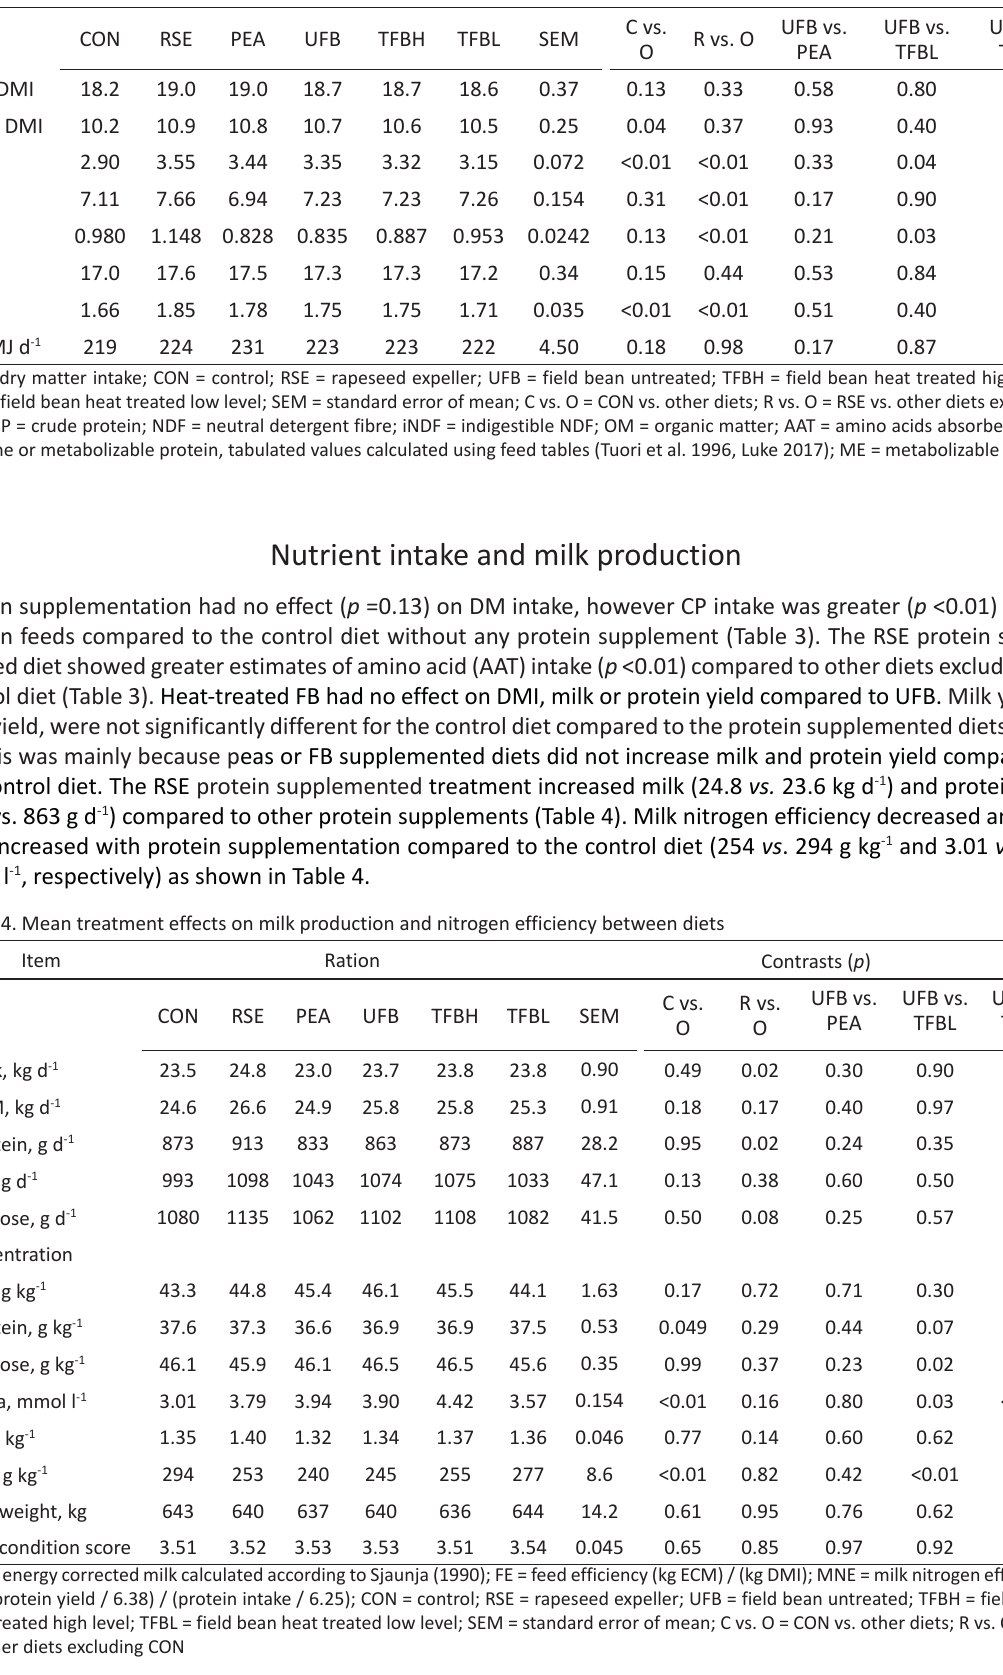
Table 3. The effect of dietary treatments on feed intake and nutrient consumption (kg d -1 ) of dairy cows Item Ration Contrasts ( p ) CON RSE PEA UFB TFBH TFBL SEM Total DMI 18.2 CP 2.90 iNDF 0.980 1.148 0.828 0.835 OM ME, MJ d -1 219 224 231 223 0.97